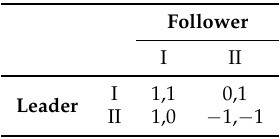
Table 16. Loss of inconsiderate